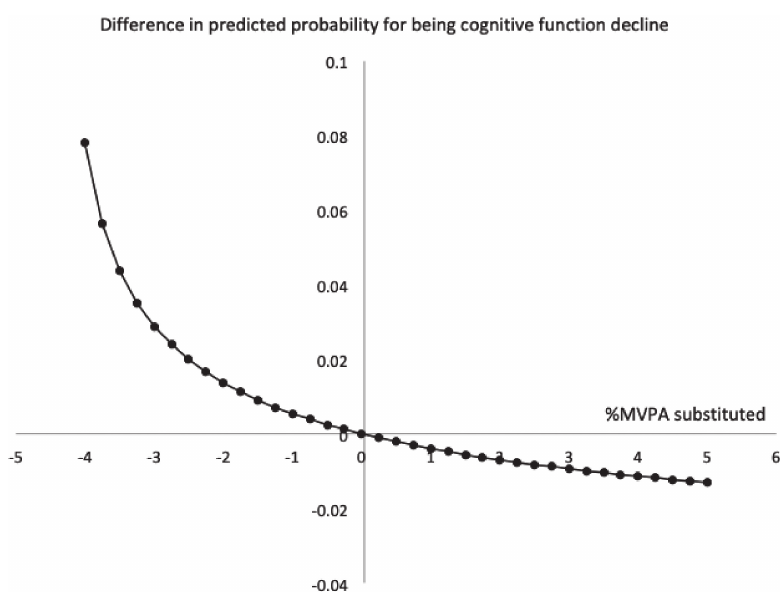
Figure 2. Di ff erence in predicted probability for being cognitive function decline with reallocation of MVPA. Analyses were adjusted for gender, age, education, body mass index, living arrangement, working status, smoking, alcohol use, past history of stroke, and medication for hypertension, dyslipidemia, and diabetes. Di ff erence in probability modelled around the population mean composition (% / day): sedentary behavior = 51.0%, light-intensity physical activity = 44.6%, moderate-to-vigorous physical activity = 4.4%. MVPA, moderate-to-vigorous physical